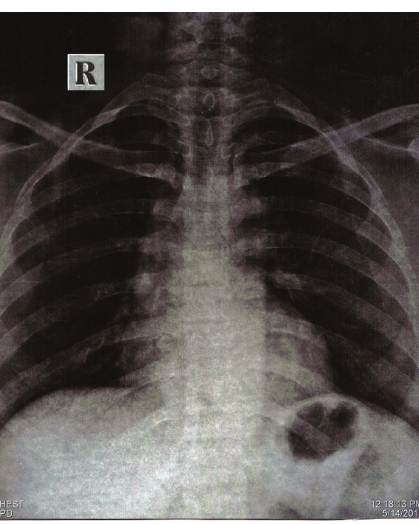
Figure 3: Abdominal radiograph after 3 days with no evidence of